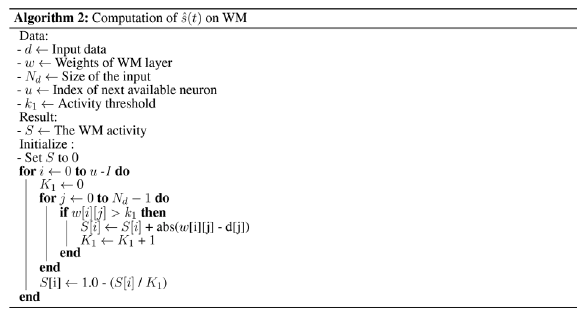
Algorithm 2. Computation of ^ s ( t ) on WM.